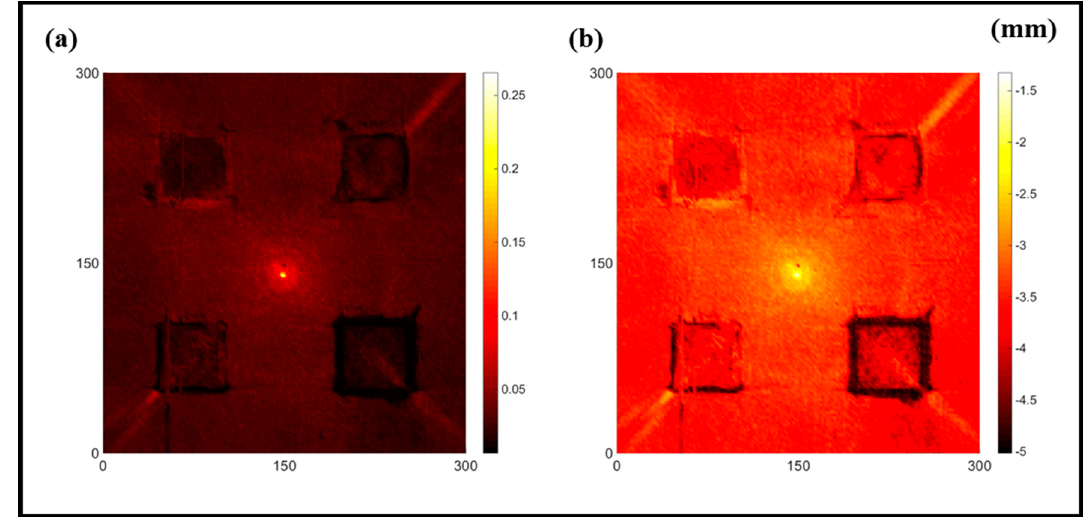
Figure 7. The RMS values distribution of Specimen 1 with damage depths of 0.5, 1.0, 1.5 and 2.0 mm at 400 μ s ( a ) w RMS ( x , y ) function; ( b ) log( w RMS ( x , y )) function.